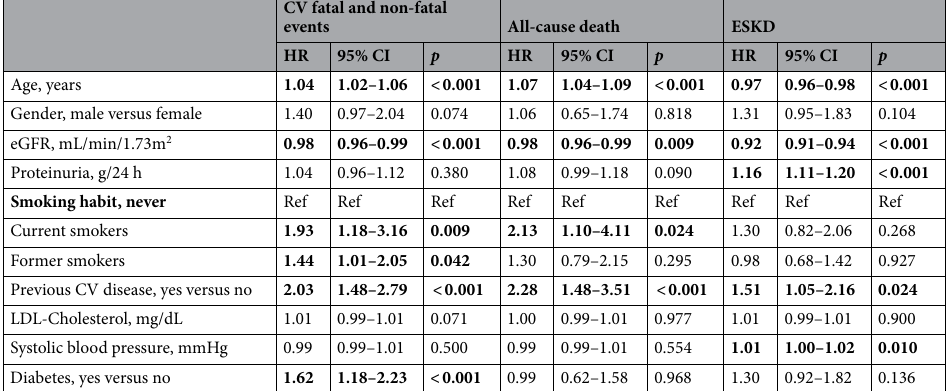
Table 3. Relative risks for cardiovascular fatal and non-fatal events, all-cause death and renal events. HR hazard ratio, CV cardiovascular, ESKD end-stage-kidney-disease, Ref reference category. Estimates with p value <0.05 are shown in bold.